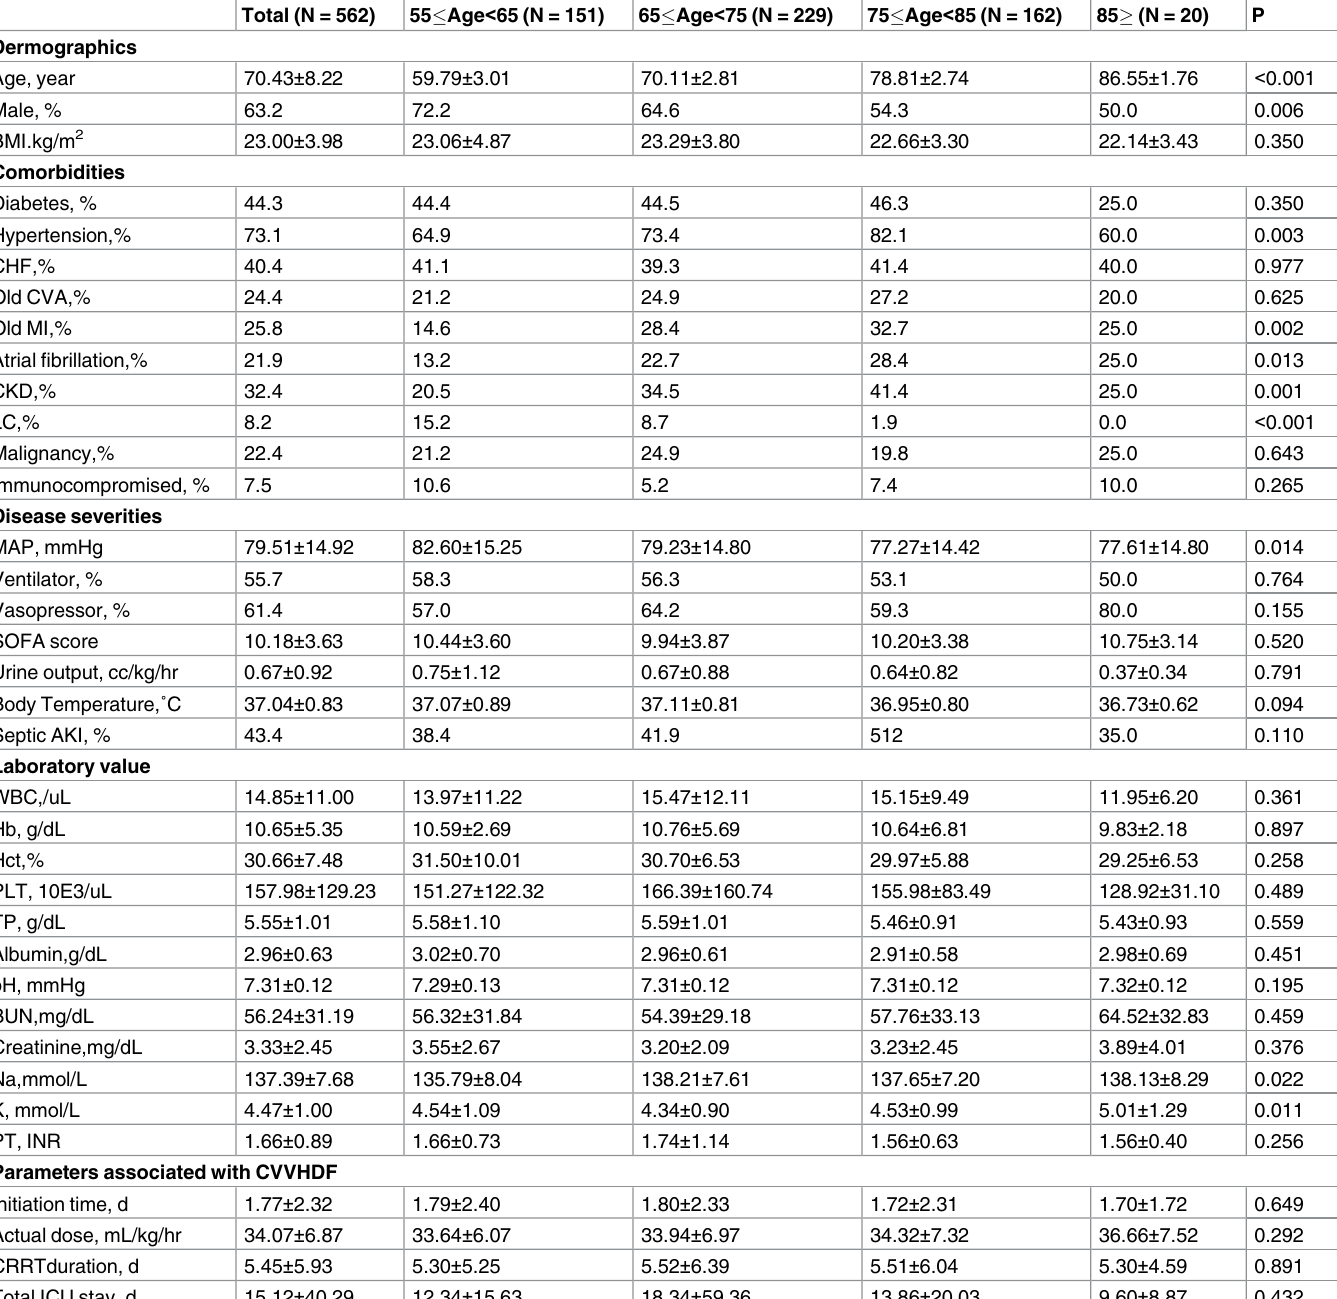
Table 2. Patient characteristics, biologic and treatment data according to age